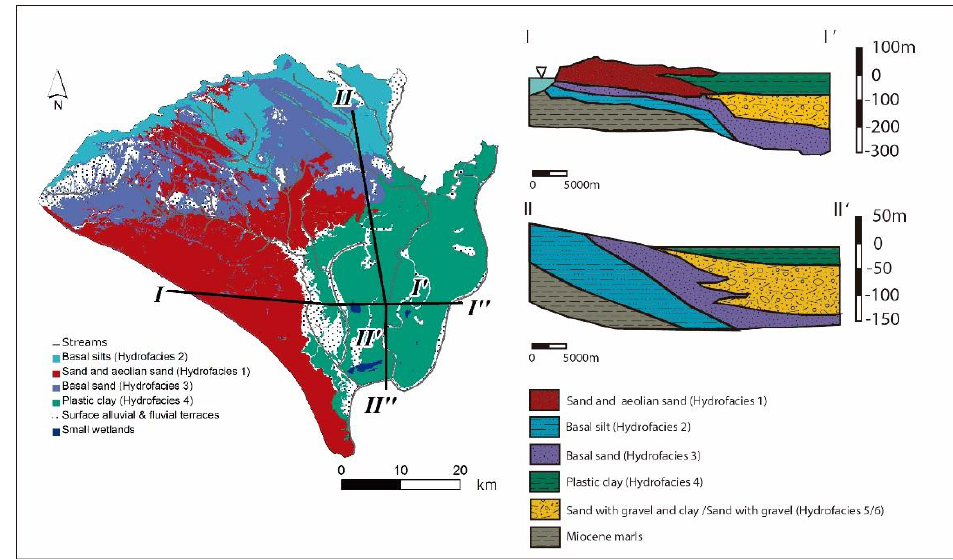
Figure 2. Left : Modified geological map (based on [35]). Right : Schematic of geological cross sections based on [6] and [32].